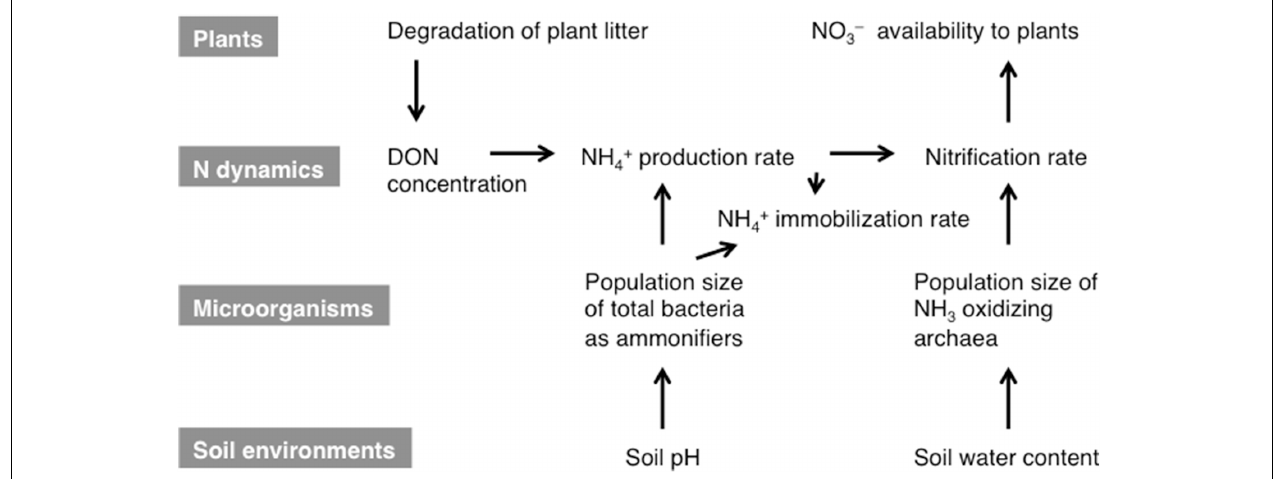
DON and the total bacterial population size as ammonifiers. The total bacterial population size is affected by the soil water content. The gross nitrification rate is affected by the NH + 4 concentration and the NH 3 -oxidizing archaea population size as nitrifiers. The NH 3 -oxidizing archaea population size is affected by the soil pH. The NO − 3 produced is available to plants because soil microorganisms prefer NH + 4 for N